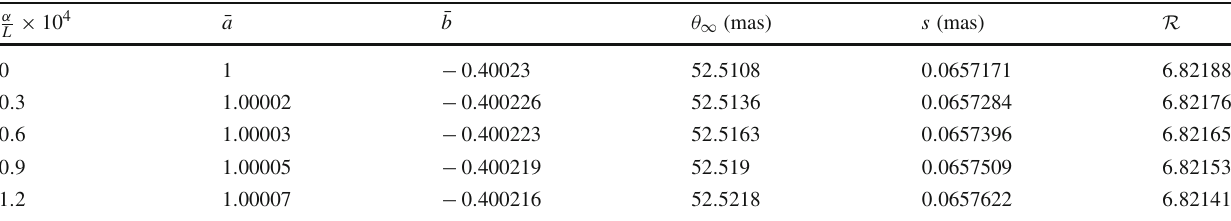
Table 4 The numerical estimation of the observables of the strong gravitational lensing for the case of Andromeda galaxy